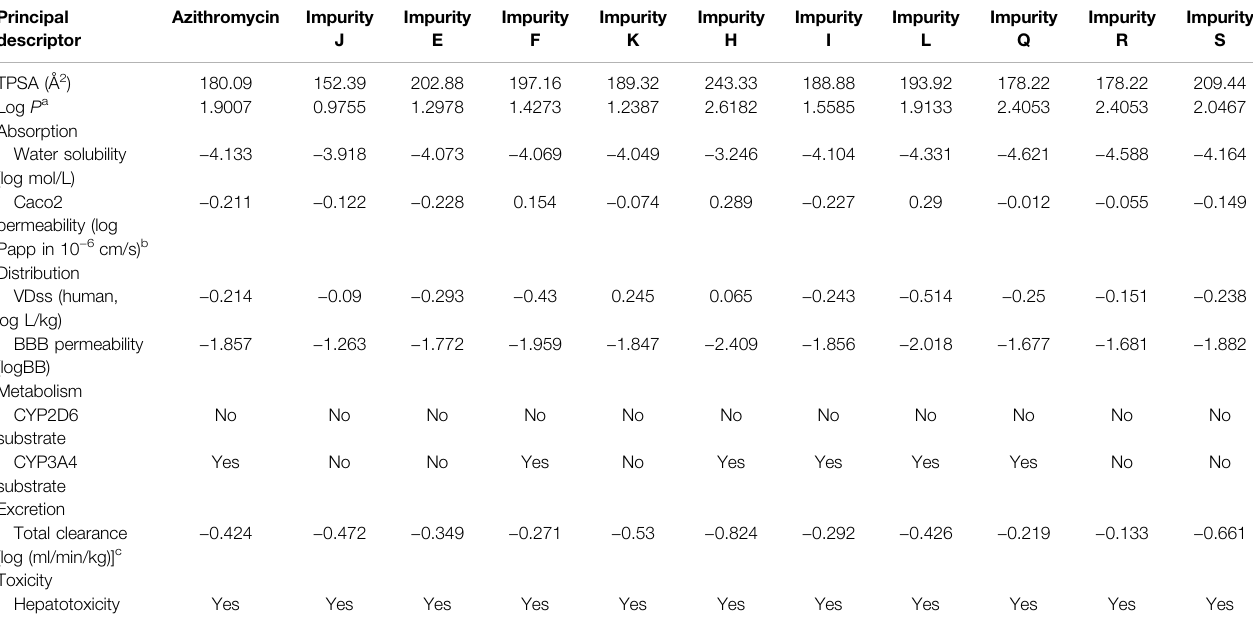
TABLE 3 | ADMET parameter prediction of azithromycin and its related impurities in this